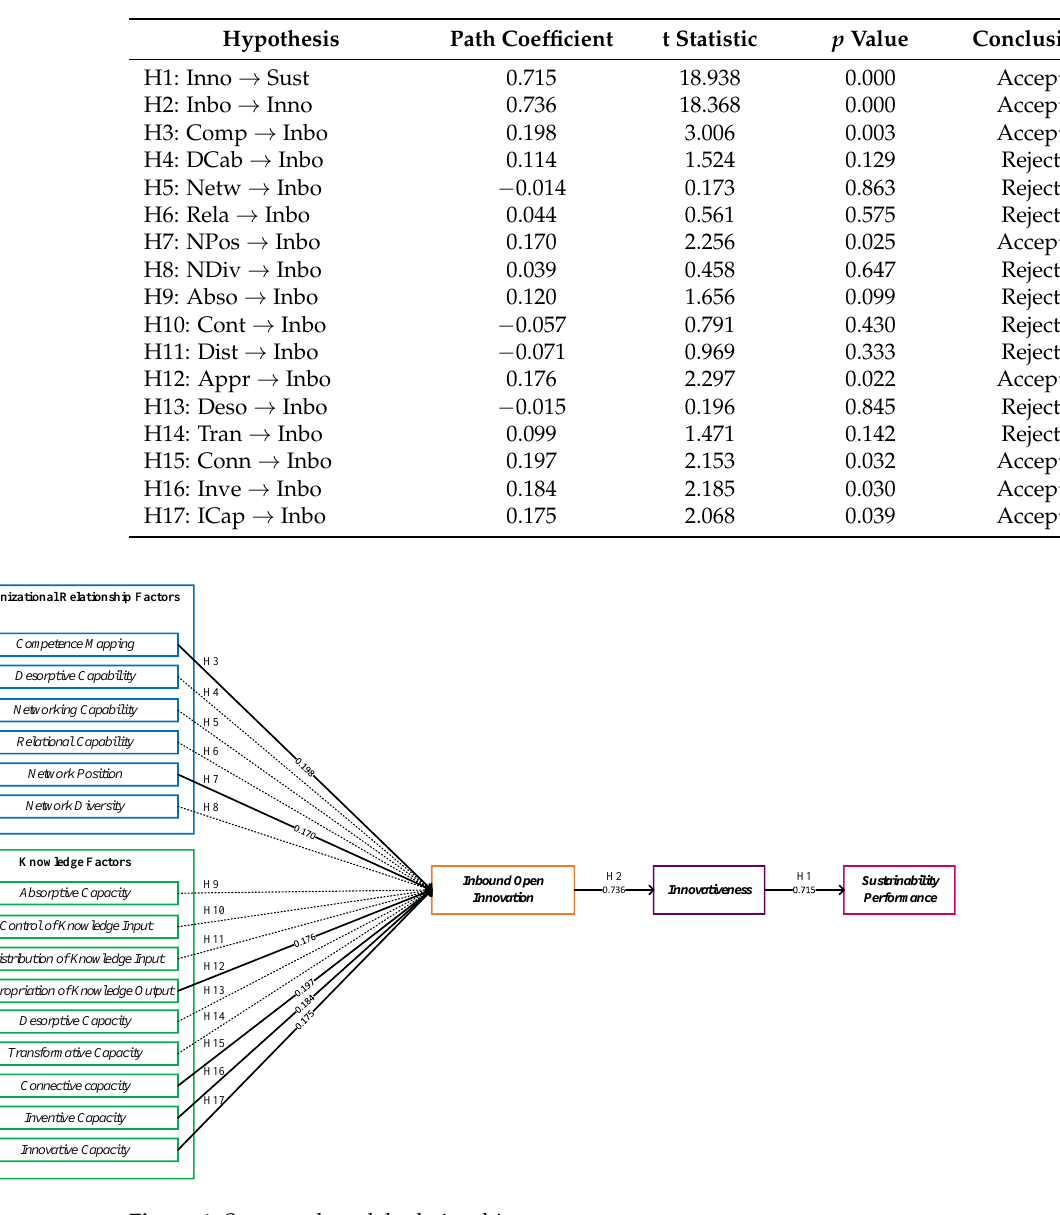
Figure 1. Structural model relationship.